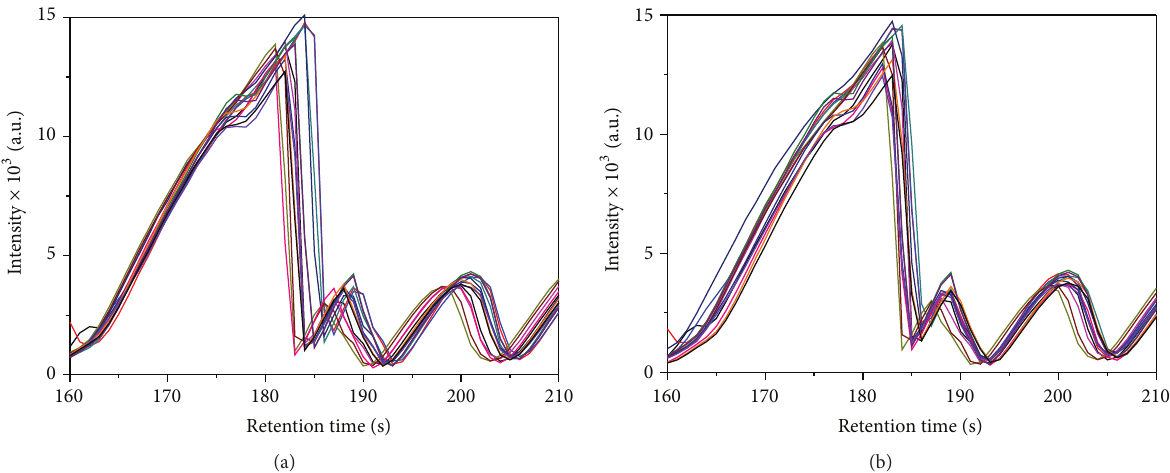
Figure 2: Superimposed sections of the GC-FID chromatographic trace: fifteen chromatograms of Repsol brand. (a) Before alignment. (b) After